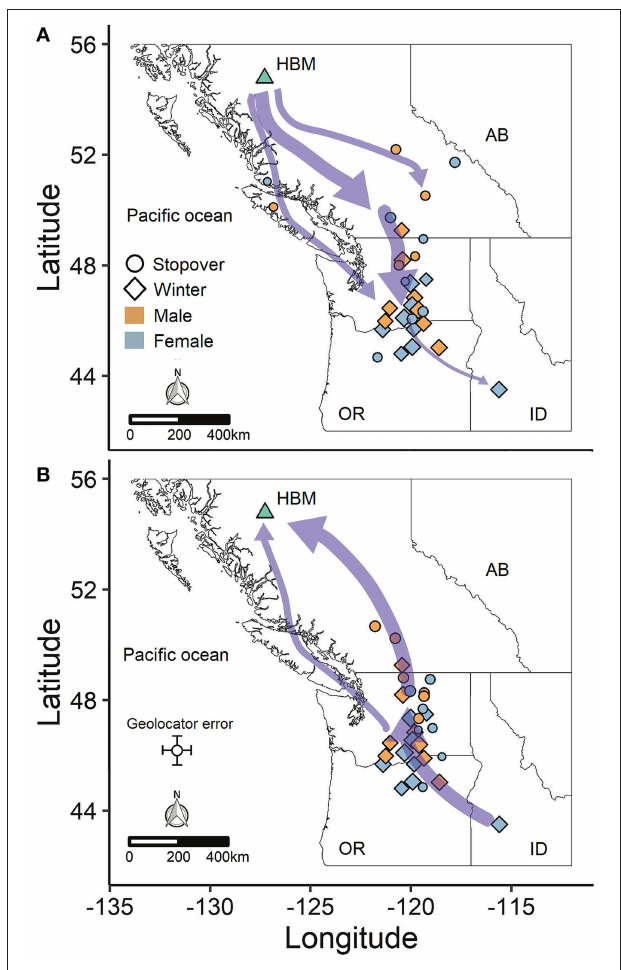
FIGURE 1 | Migration routes between the breeding site (HBM) and winter sites for (A) autumn and (B) spring migration. The purple arrows are weighted to depict the most common migration routes. Points indicate winter sites (diamonds) and stopovers > 14 days long (circles) and are weighted by the number of days at each site. Stopovers < 14 days long are not shown for the sake of clarity. Each individual is represented by at least one winter site and up to one or two stopover sites ( n = 17